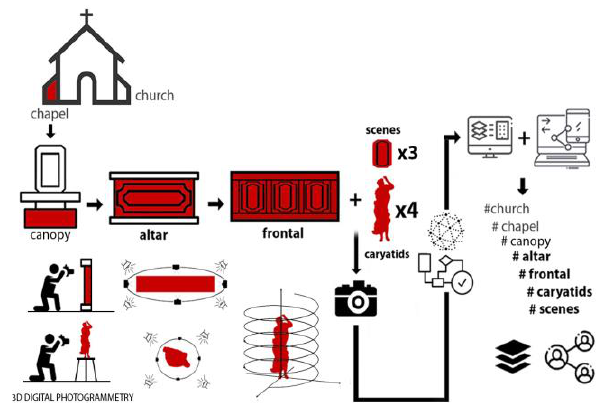
Figure 3 . Scan to HBIM: from macro to